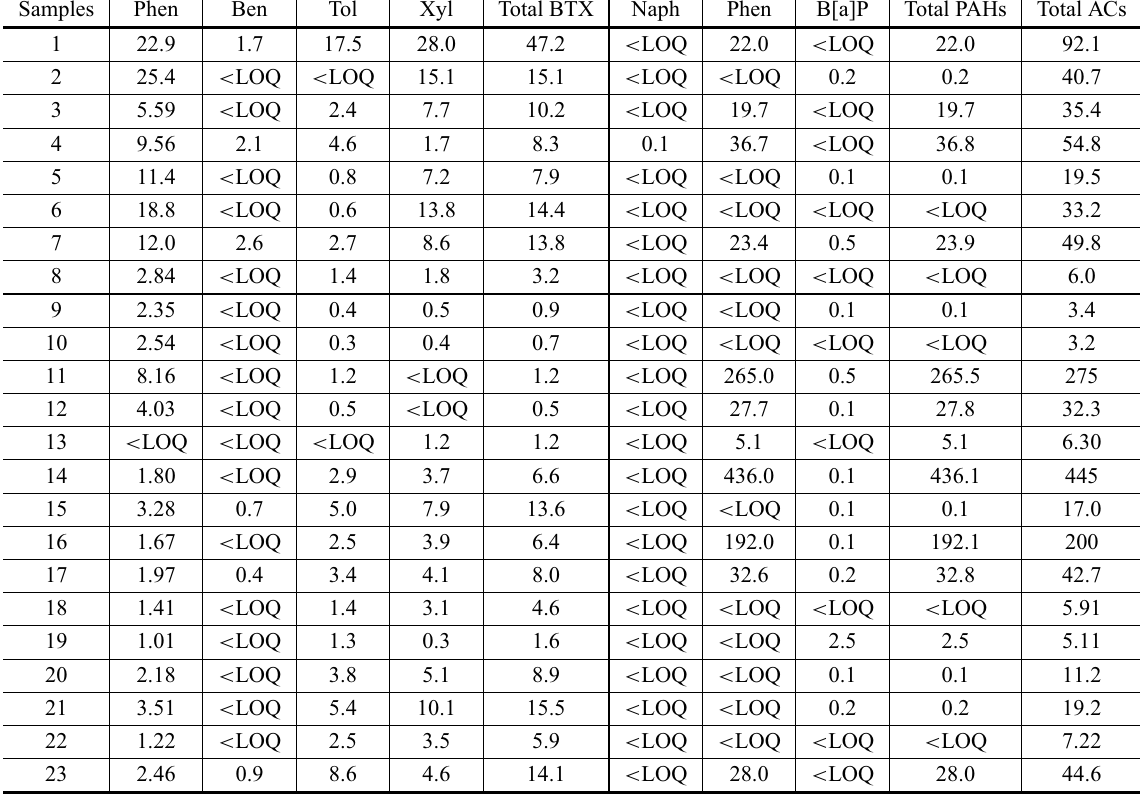
Aromatic compound concentrations ( μ g/g) in sediments from Suruí Mangrove.